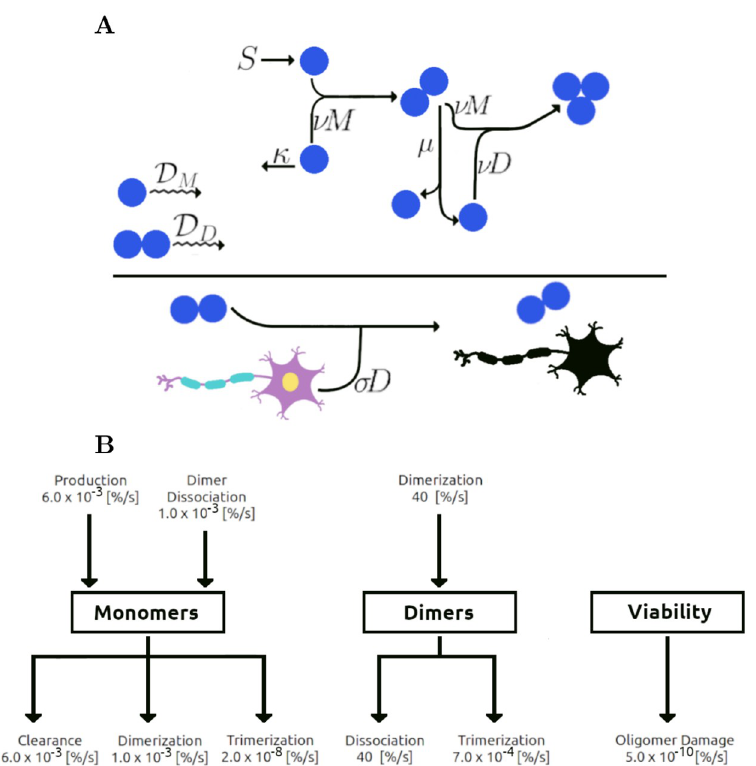
Fig 1. Model scheme. A : Monomers are produced at rate S (zeroth order) and cleared at a rate κ (first order). Two monomers combine to form a dimer with rate constant ν (second order) and a dimer can dissociate at rate μ (first order) into two monomers. Monomers and dimers can combine to form trimers at rate ν (second order), with negligible backwards reactions. Neurons are killed at a rate σ times the dimer concentration. Thus, as the dimer concentration rises, so does the speed of neuronal death. Monomers and dimers diffuse with diffusivities D respectively. B : Representative production/loss rates of individual components when concentrations are at their baselines values in Table 1, without the rates changing with age. Incoming arrows represent gain/production; outgoing arrows represent loss/clearance. For example, in each second, 40% of the dimer concentration is lost due to dissociation (dimers have a very short lifespan) and gained from dimerization illustrating that the monomer-dimer equilibrium is fast relative to other equilibria, whereas cell viability is lost very slowly.